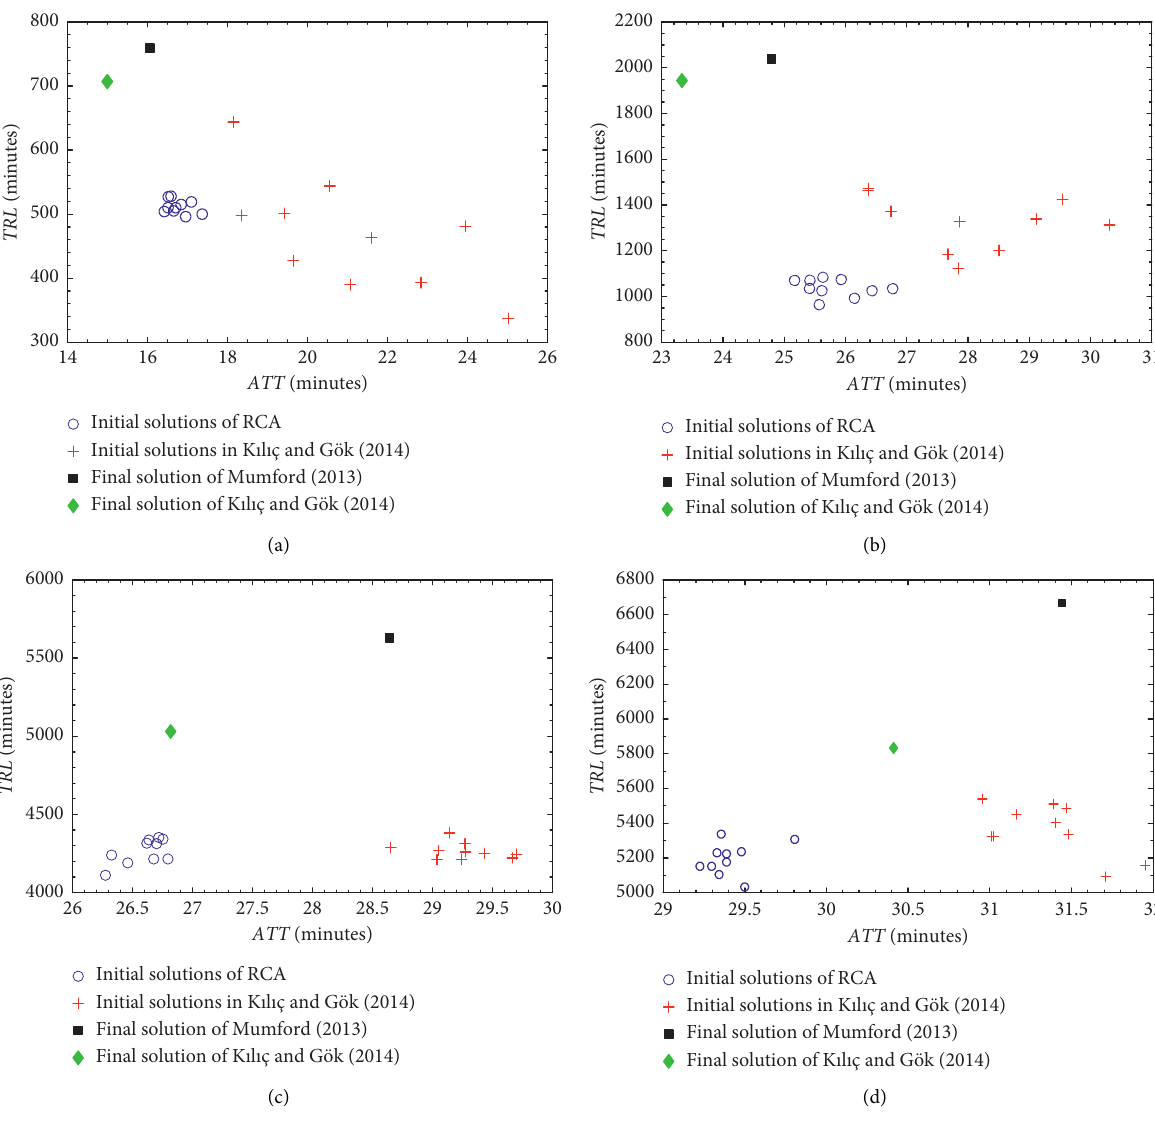
Figure 7: Comparisons of the initial solutions for Mumford’s networks. (a) Mumford0 (| R | � 12). (b) Mumford1 (| R | � 15). (c) Mumford2 (| R | � 56). (d) Mumford3 (| R | � 60). Table 4: Initial solutions for Mumford’s networks compared to Kilic and Gok [14].